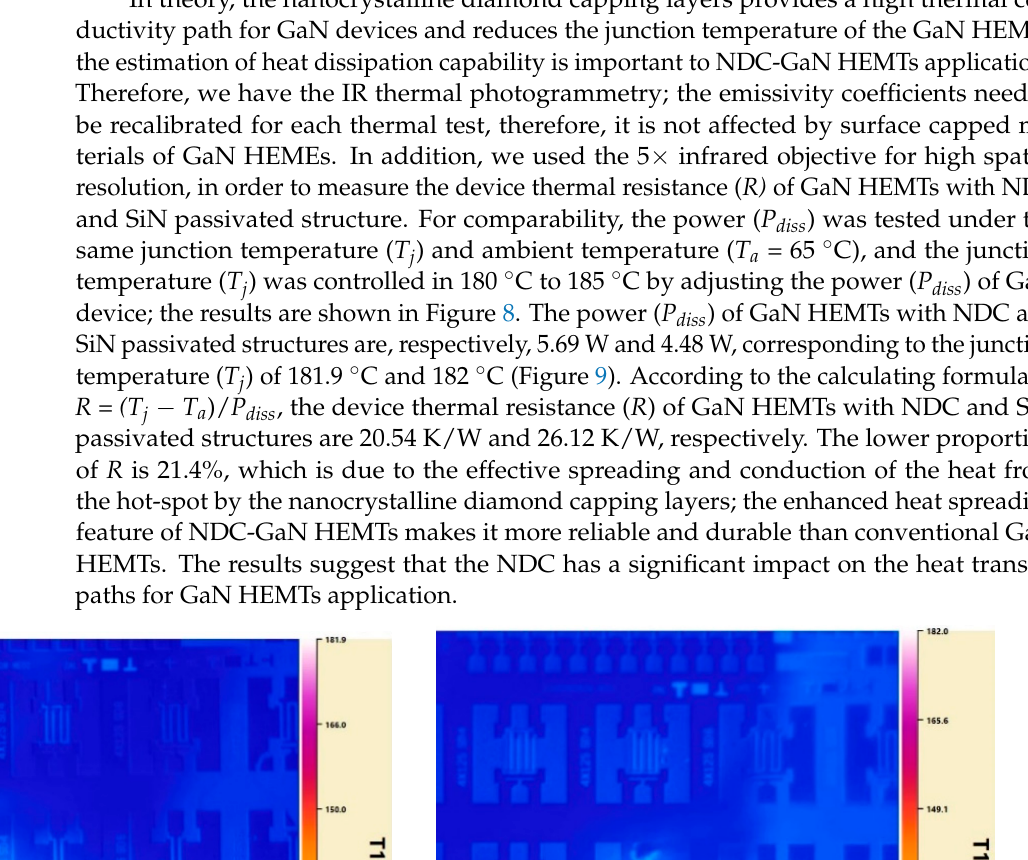
Figure 9. The temperature distribution and junction temperature of GaN HEMTs with NDC ( a ) and SiN ( b ) passivated structures of thermal simulation calculations; the temperature gradient around heat source regions (the center regions of gate) of GaN HEMTs with NDC ( c ) and SiN ( d ) passivated structures.